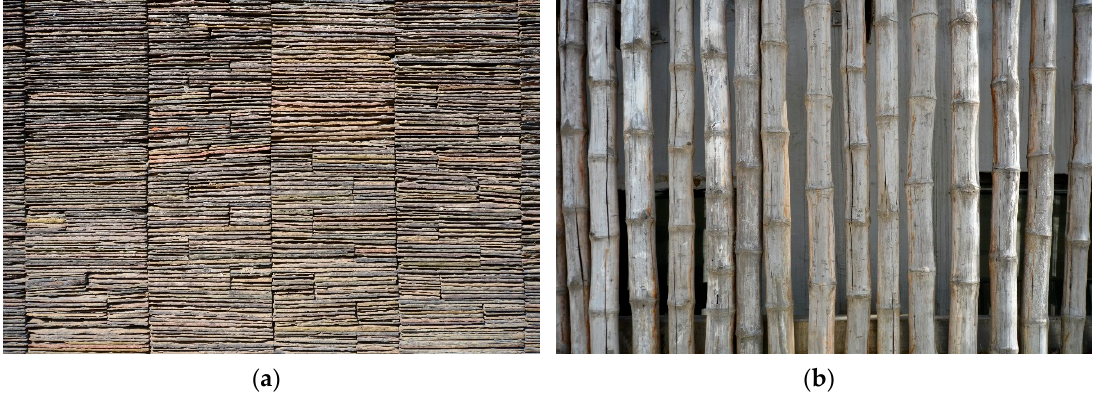
Figure 35. Cladding materials used in Dilli Haat Janakpuri: ( a ) Delhi Quartzite Stone and ( b ) bamboo (Photo: Author).